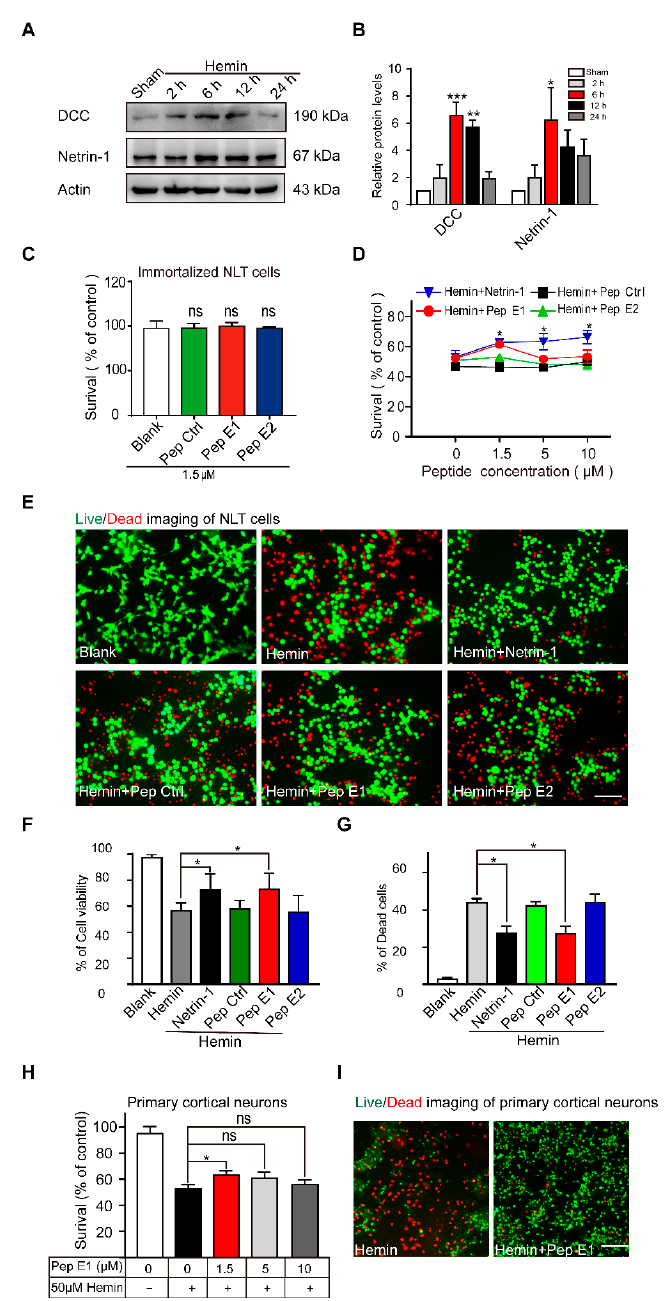
Figure 4. Peptide E1 ameliorates hemin induced cell death in vitro. ( A ) Western blot of Netrin-1 and DCC in cultured NLT cells exposed to Hemin (60 µ M). ( B ) Quantitative analysis of the western blot results shown in ( A ). n = 3. ( C ) CCK-8 assays showed that series peptides were not changed cell viability. n = 4. ( D ) 1.5 µ M Pep E1 preserved NLT cell viability when added well after